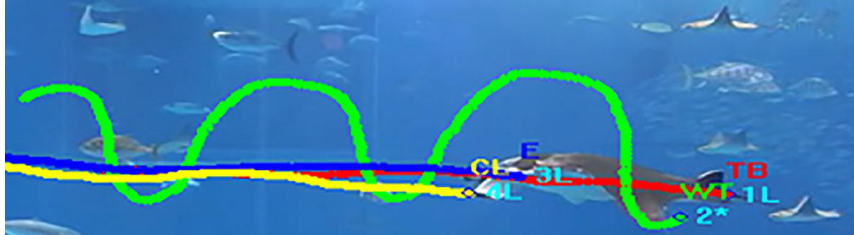
Figure 7. Pathways following the movements of the fin tip (green), tail base (red), and eye (blue) of a swimming manta.